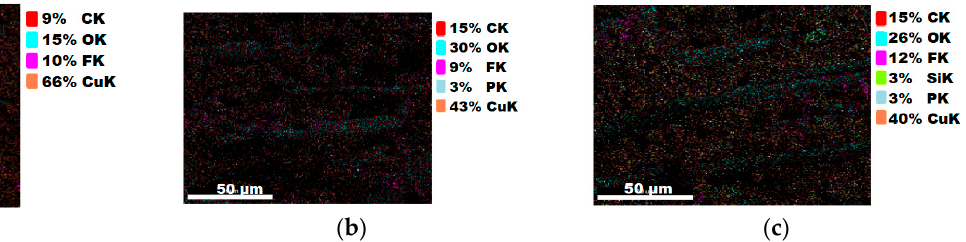
Figure 9. Smart elemental mapping overlay for sample 4: ( a ) untreated with artificial perspiration; ( b ) treated with acid perspiration; ( c ) treated with alkaline artificial perspiration.